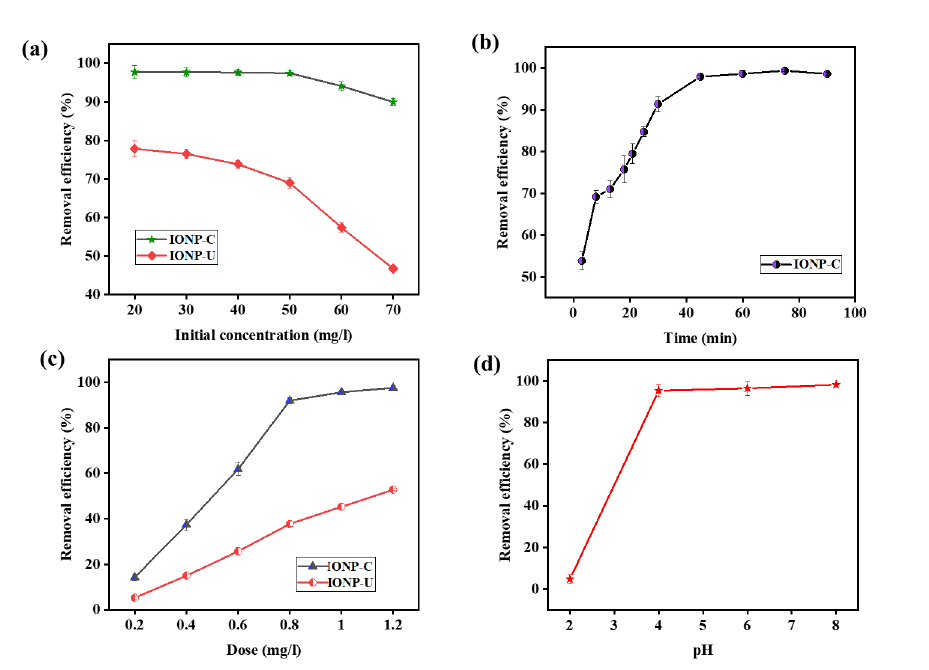
Figure 7. (a) Effect of adsorbent dose, (b) Effect of initial concentration, (c) Effect of pH, (d) Effect of contact time